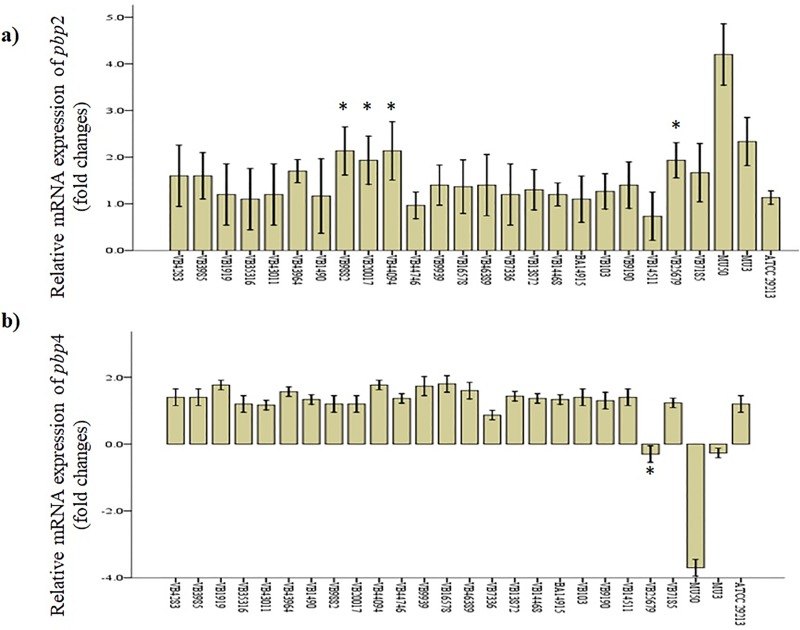
Quantitative transcription of pbp2 and pbp4 genes in whole-genome sequenced hVISA strains (n = 23).Data are indicated as mean and standard deviation. Error bar represents the standard deviation of three mean values. pbp2 upregulation was significant in VB9882, VB20017, VB44094, and VB25679 compared to S. aureus ATCC 29213 (marked with a single asterisk, p < 0.05). pbp4 upregulation was significant in VB25679 compared to S. aureus ATCC 29213 (marked with a single asterisk, p < 0.05).